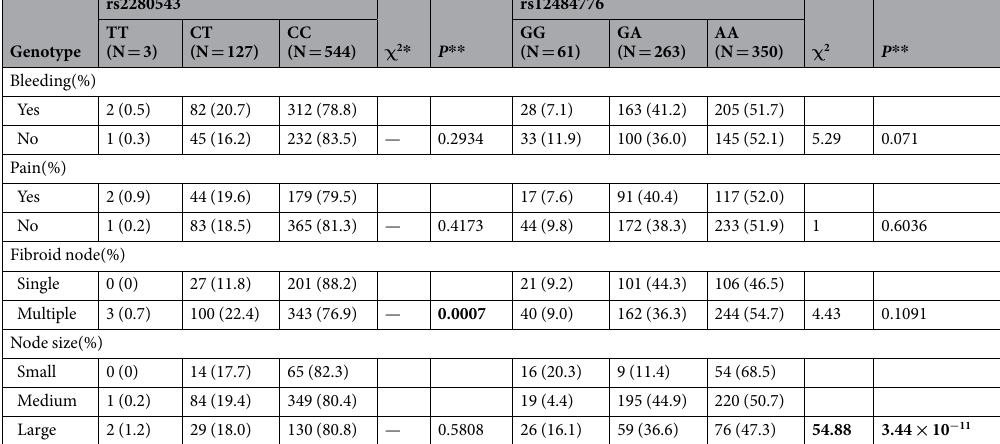
Table 4. Genetic associations of rs2280543 and rs12484776 with clinical characteristics of UL patients. * Fisher exact tests were applied when there were sparse cells and therefore no χ 2 statistics were reported. Significant results were highlighted in bold. ** P value threshold after Bonferroni corrections was 0.05/8 ≈ 0.00625.